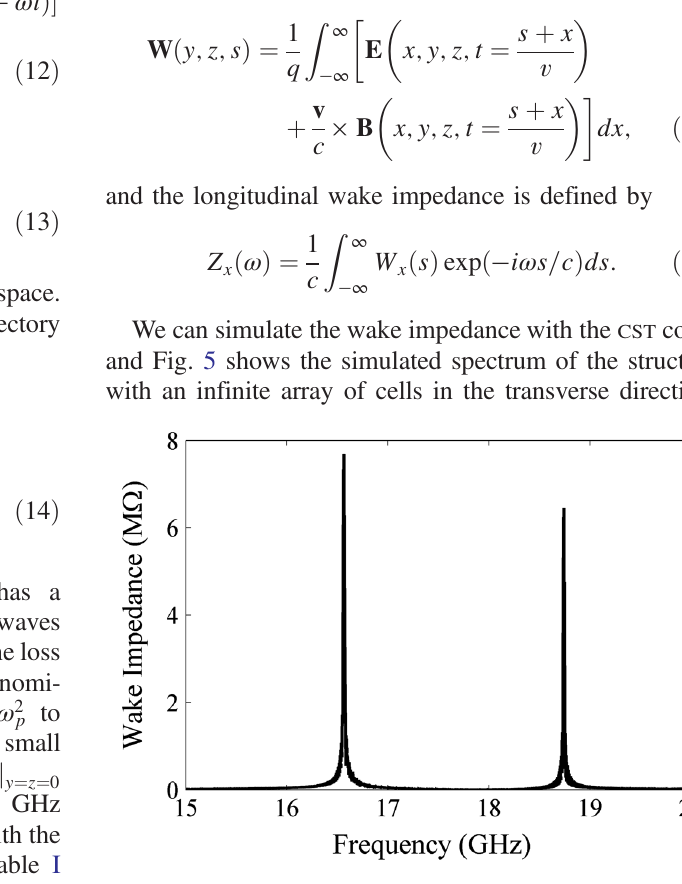
FIG. 5. Longitudinal wake impedance spectrum. Peaks are located at 16.6 and 18.7 GHz, corresponding to eigenmode 1 and 3,